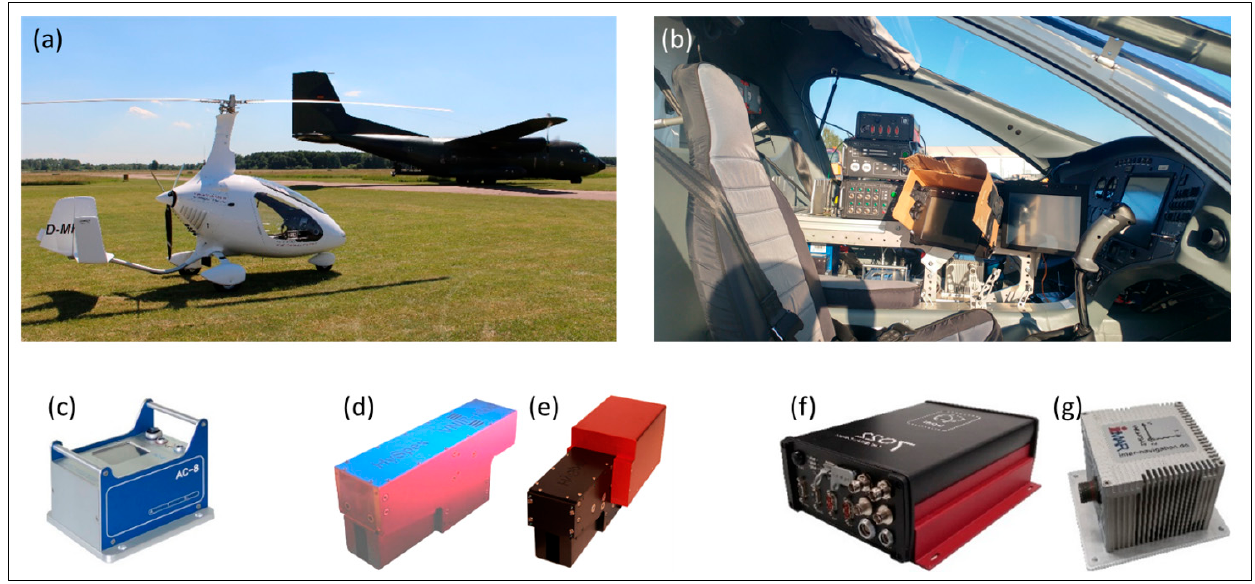
Figure 3. ( a ) Image of the gyrocopter from the Institute for Geoinformation and Surveying of HSA and ( b ) the measurement technology on the co-pilot’s seat. Integrated sensor technology: ( c ) Nikon D800e modified by ATS, ( d ) HySpex VNIR, ( e ) HySpex SWIR from Neo, ( f ) GNSS receiver from PPM and ( g ) IMU from iMAR.